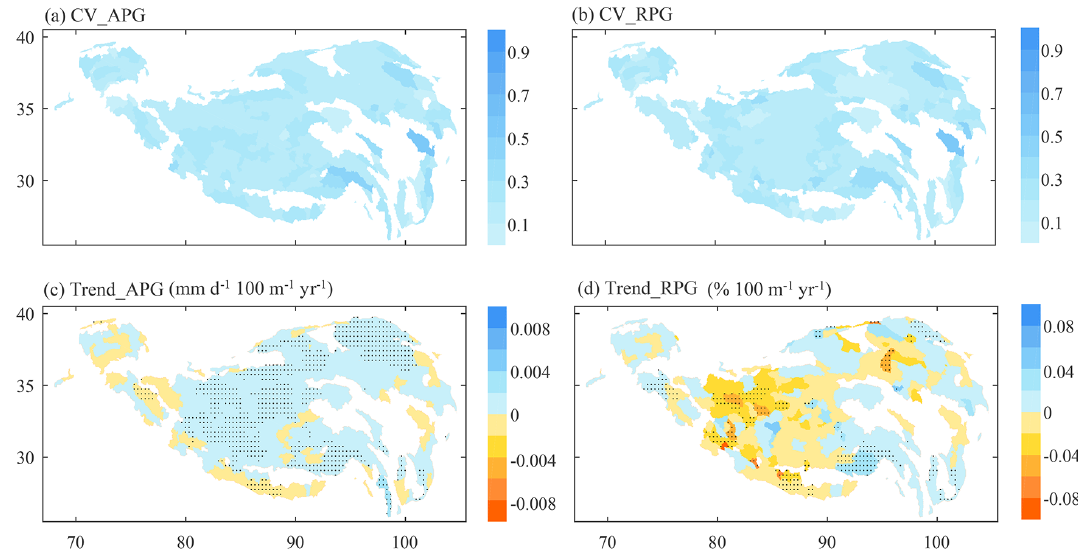
Figure 6. Spatial distribution of (a) and (b) the coefficient of variation (CV) and (c) and (d) the trend for annual APGs and RPGs during 1980–2018. The dots in panels (c) and (d) represent a trend significant at the 95% confidence level. The CV and trend are calculated only for sub-basins without missing APG or RPG during